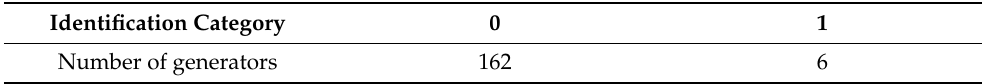
Table 6. Identification results of economic withholding of generators. Identification Category